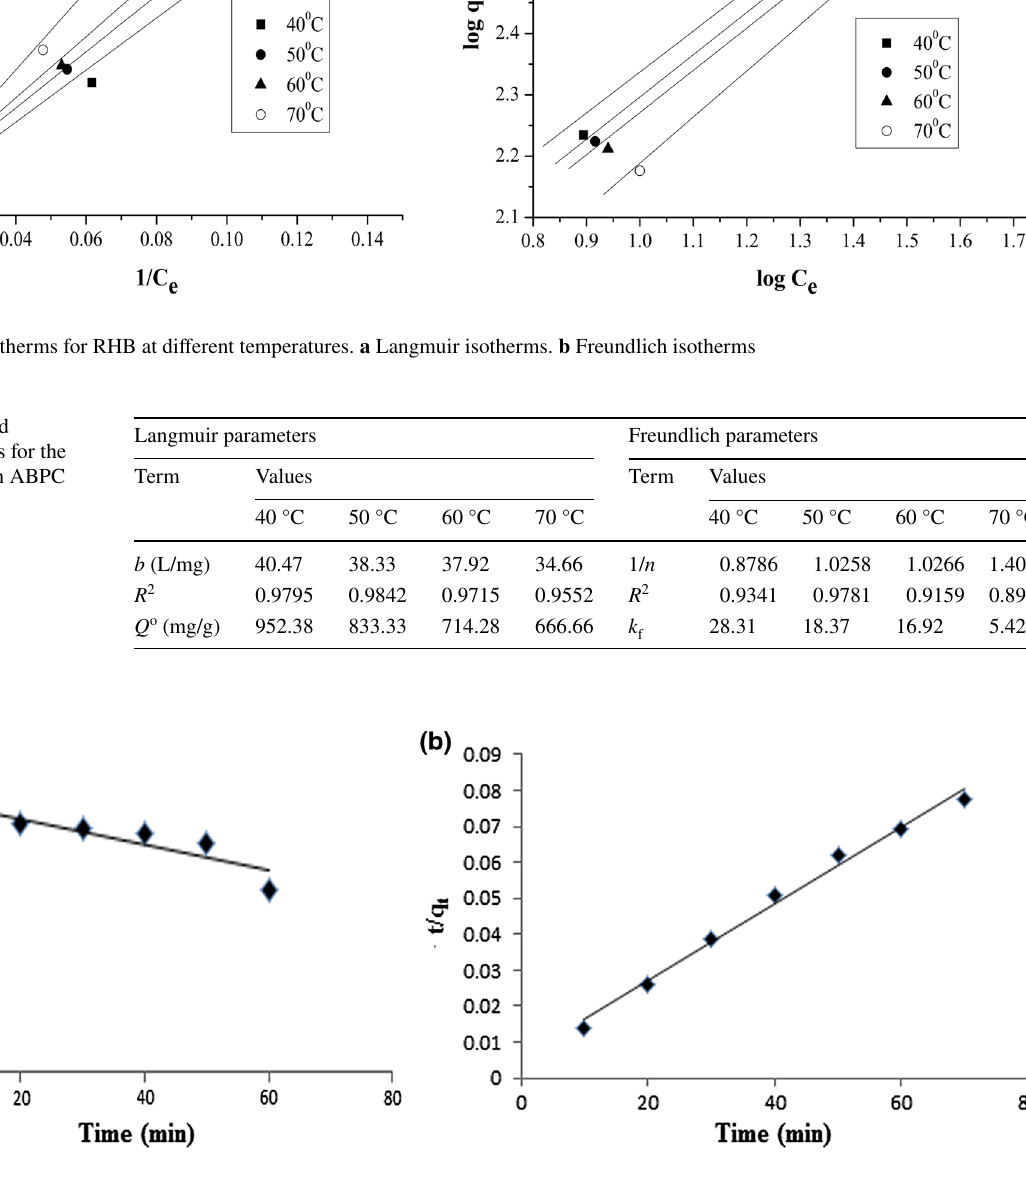
Fig. 3 Different kinetic models for adsorption of RHB on ABPC. a Pseudo-first order. b Pseudo-second